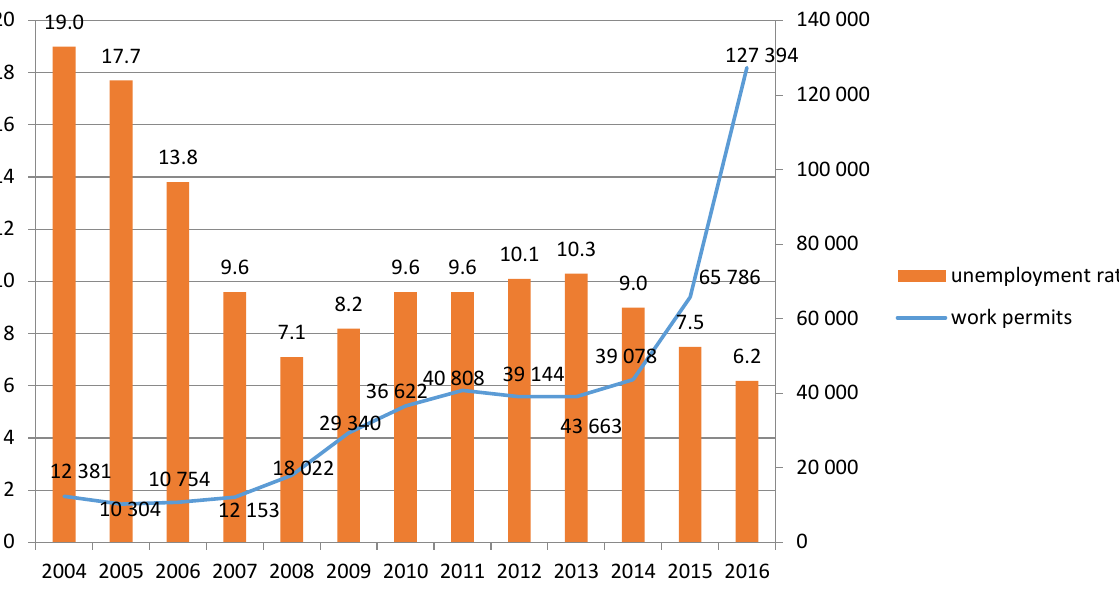
Figure 1. Work permits issued (right axis) and unemployment rate (left axis) in Poland, 2004–2016